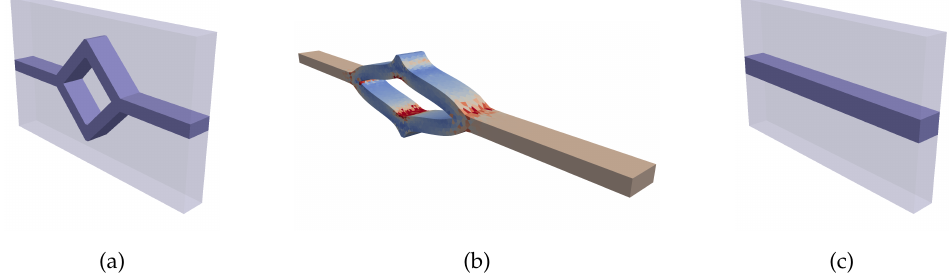
Figure 9. ( a ) Cuboidal microstructure with hashlike inclusion phase. ( b ) Deformed state under uniaxial tension loading. Only inclusion is shown, coloring indicates P xx . ( c ) Straight inclusion substitute microstructure, leading to a comparable effective